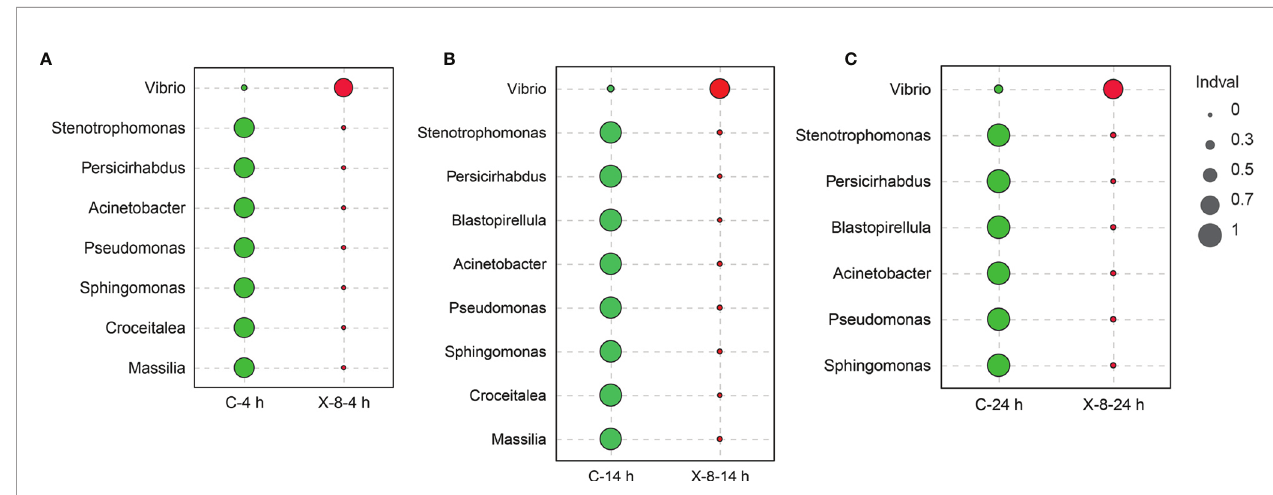
FIGURE 4 | The succession of indicator species at (A) 4 h; (B) 14 h; (C) 24 h. The sizes of the circle represented Indval; green represented control group, red represented PpX-8 infected group.